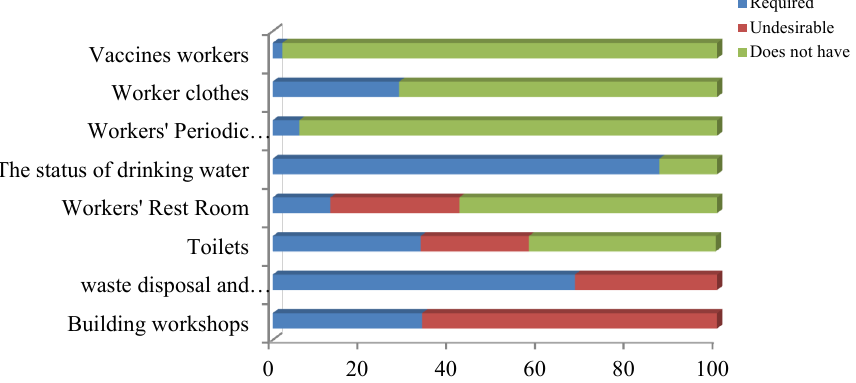
Fig. 3. Comparative diagram of environmental health factors in recycling